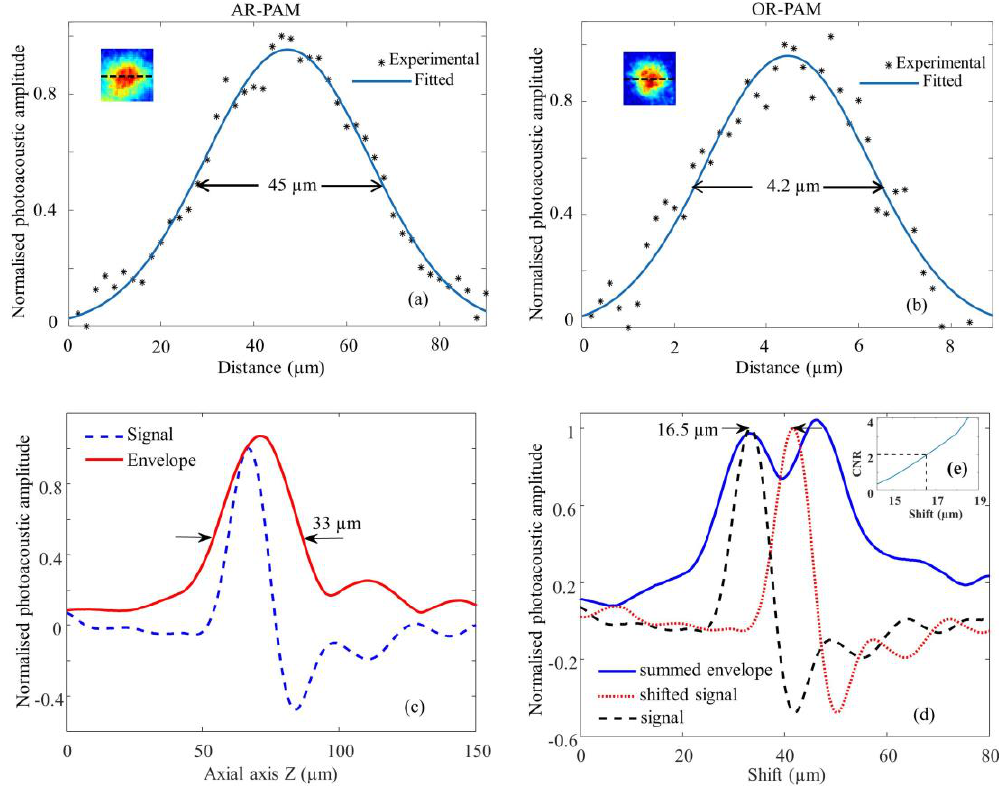
Figure 2. Spatial resolution test of the AR-OR-PAM system: Lateral resolution estimated by imaging gold nanoparticles ~100 nm diameter, Black (*) dots: photoacoustic signal; blue line: Gaussian-fitted curve; ( a ) AR-PAM; ( b ) OR-PAM. The inset shows the representative AR-PAM image in ( a ) and OR-PAM image in ( b ) of the single gold nanoparticle; ( c ) Photoacoustic axial spread profile and its envelope; ( d ) Simulated photoacoustic shift-and-sum A-line signals. The dashed line and dotted line indicate two photoacoustic signals 16.5 µm apart. The solid line indicates the summed envelope of the two shifted signals; ( e ) Contrast-to-noise ratio (CNR) versus the shift distance between the two signals.